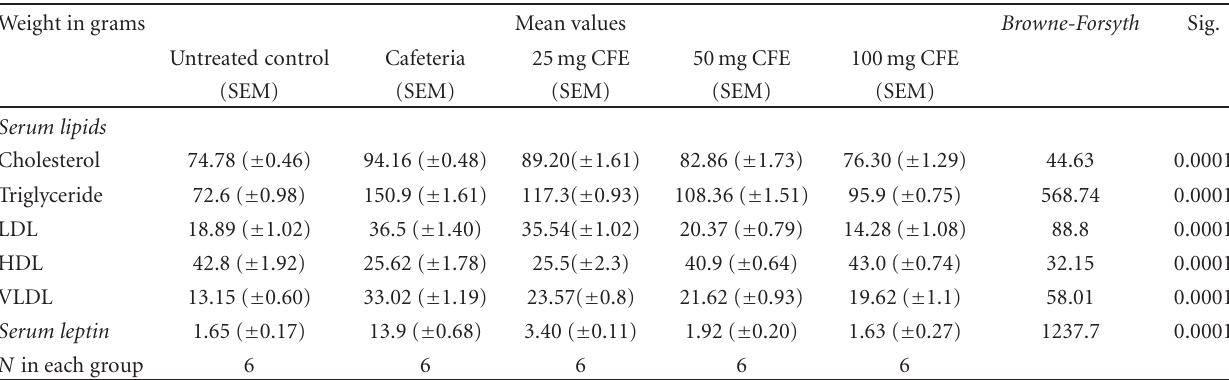
Table 2: Obesity indicators and impact of